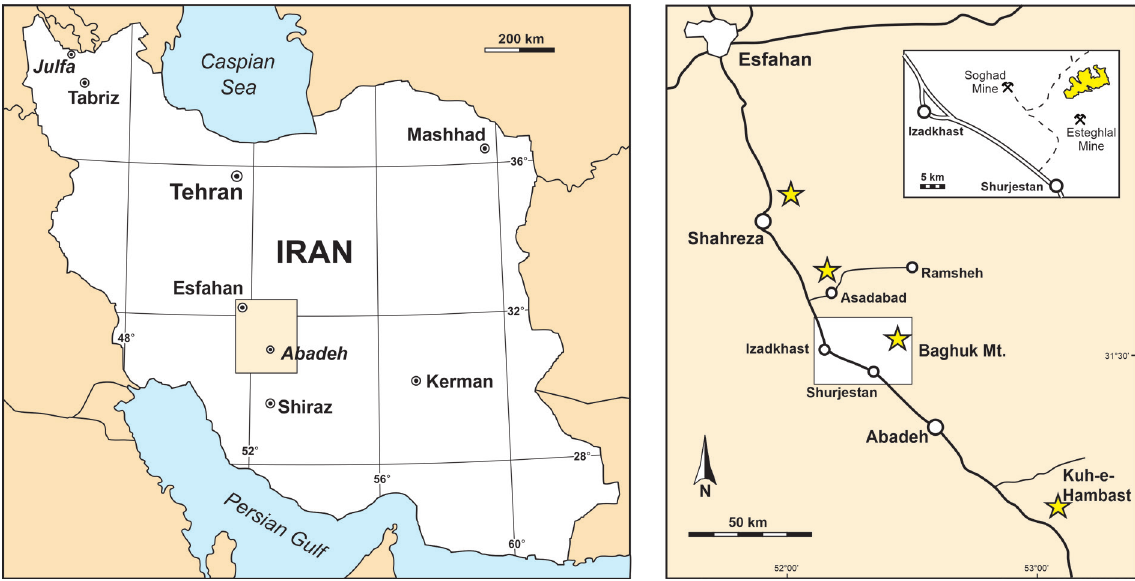
Fig. 1. Geographic position of Permian–Triassic boundary sections at Baghuk